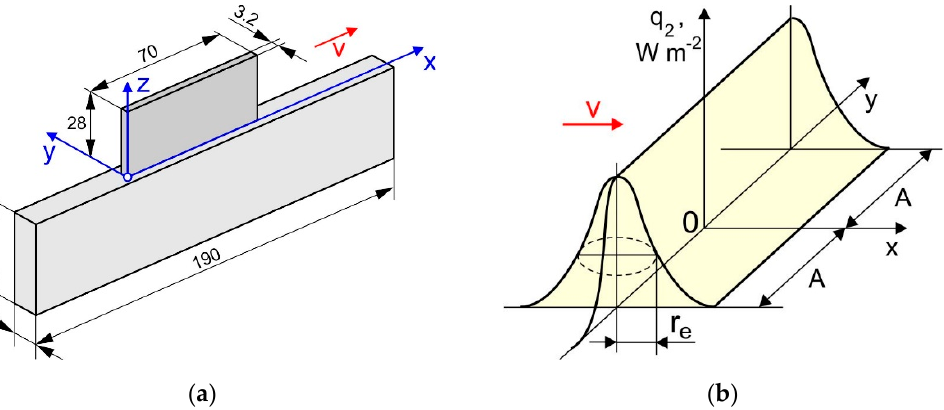
Figure 1. Schematic of ( a ) the sample and ( b ) the power density distribution of a linearly oscillating laser beam.